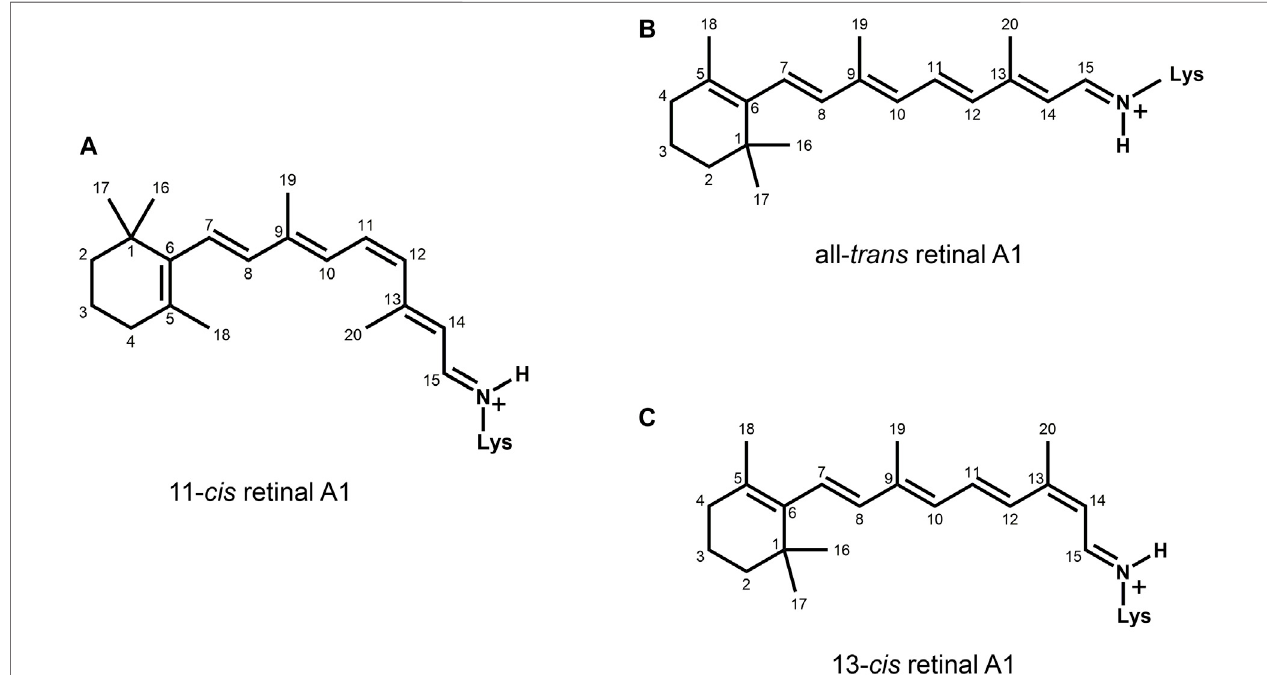
FIGURE 1 | Chemical structures of the most common chromophore con fi gurations in the rhodopsin families. The type-2 pigments contain an 11- cis , 15- anti retinylidene Schiff base of retinal A1 (A) in the “ dark state ” (or “ ground state ” in photophysical terminology), which is photo-excited into the all- trans con fi guration. The Type-1pigmentscontaintheall- trans con fi guration (B) inthe “ darkstate. ” Thisisphoto-excited intothe13- cis ,15- anti con fi guration (C) ,whichthermally relaxesandre- isomerizes, returning to the ground state. The ring-polyene chain orientation is different for type-2 (6-s- cis ) and type-1 (6-s- trans ) rhodopsins.